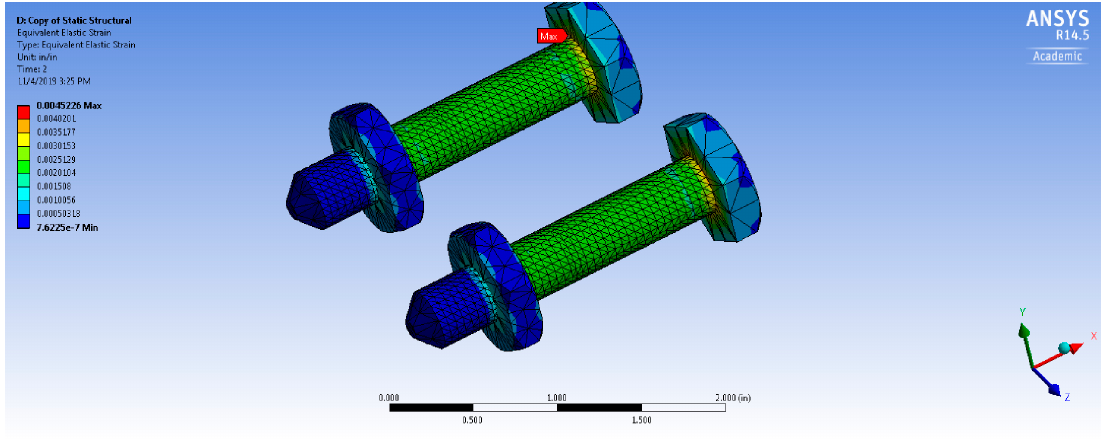
Figure 8. The bolt equivalent static strains as a function of the reaction